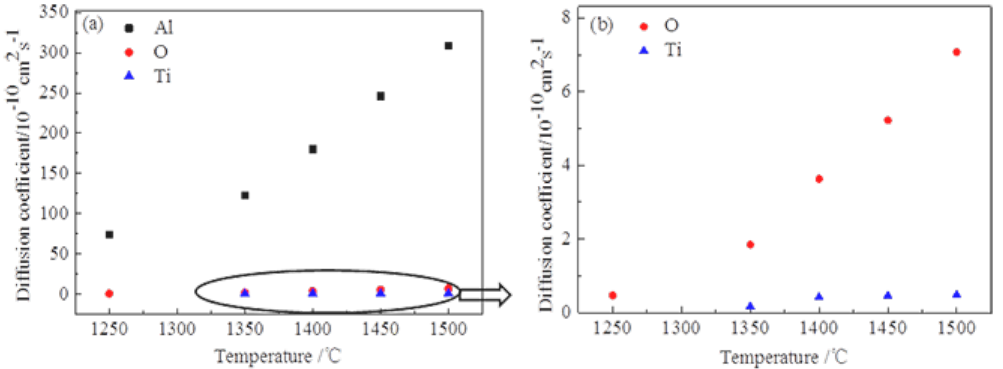
Figure 10. Di ff usion coe ffi cients of elements at di ff erent sintering temperatures: ( a ) di ff usion coe ffi cients Figure 10. Diffusion coefficients of elements at different sintering temperatures: ( a ) diffusion of Al, O, Ti; ( b ) di ff usion coe ffi cients of O, coefficients of Al,O,Ti; ( b ) diffusion coefficients of O,Ti.